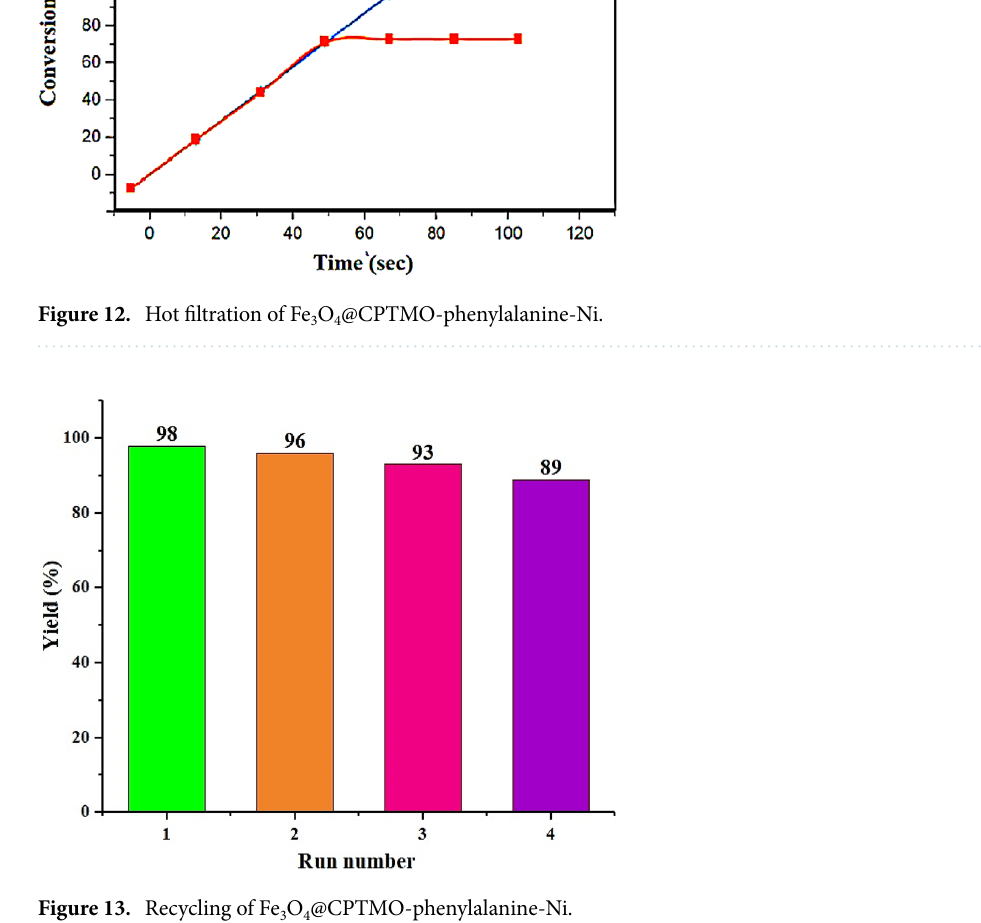
Figure 13. Recycling of Fe 3 O 4